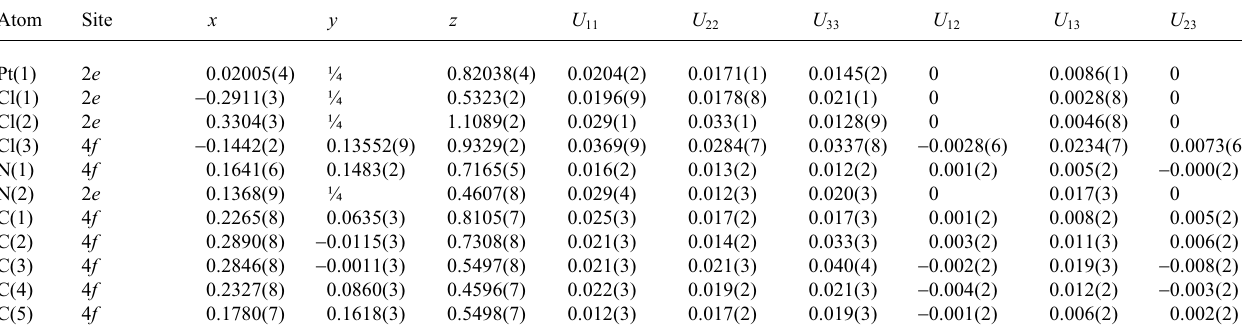
Table 3. Atomic coordinates and displacement parameters (in Å 2